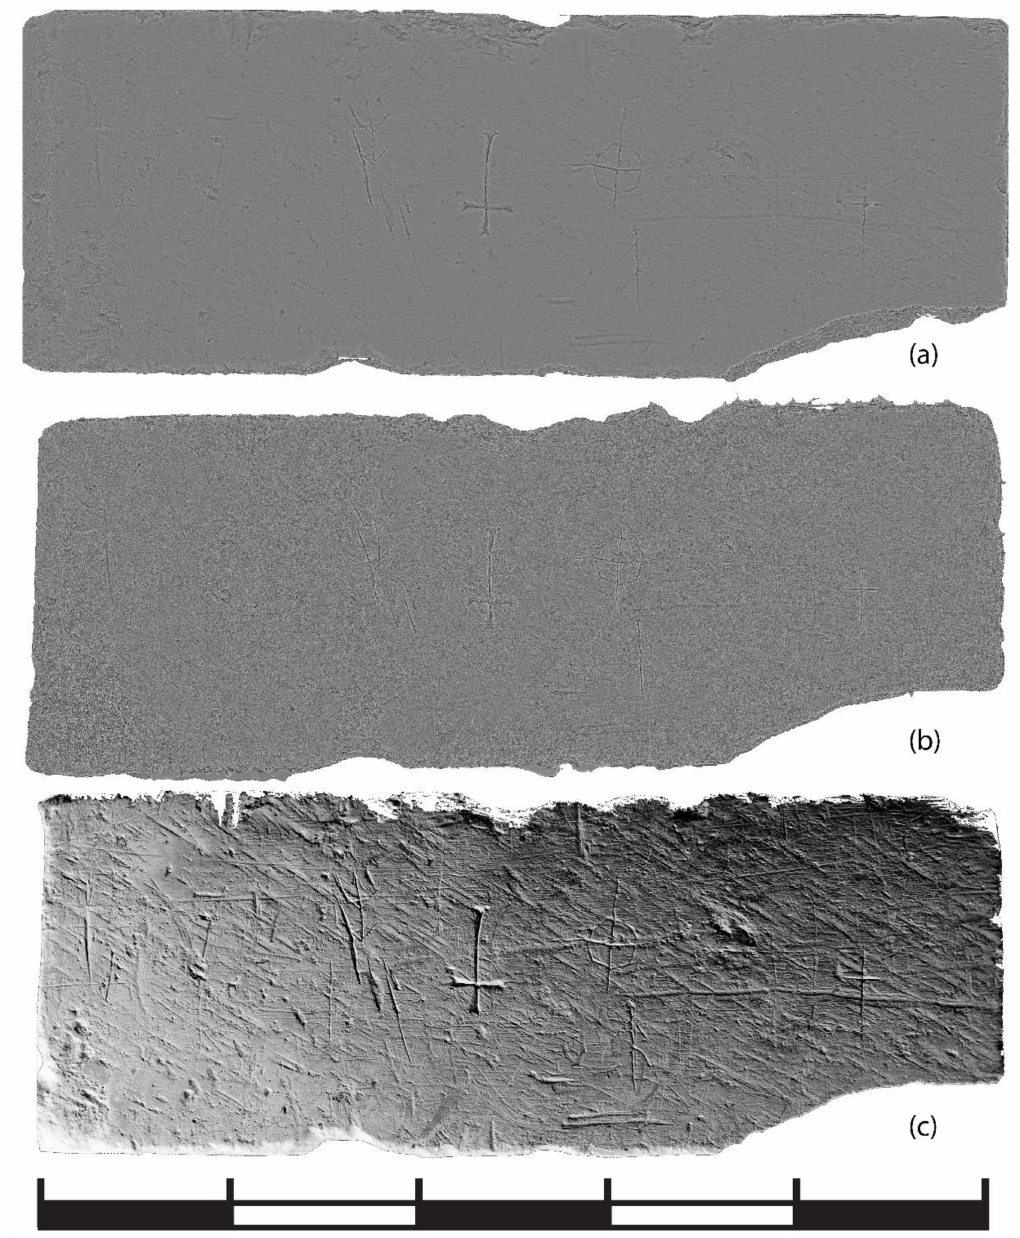
Figure 3. Surface A. ( a ) IBM-RealityCapture (RC); ( b ) Combo 1-RC; and ( c ) Highlight RTI (H-RTI). The scale shown is 50 cm. The RTI model is the most detailed, while the Combo 1 is the most detailed of the 3D models. For practical purposes, only a selection of the results is shown here. All result images, including of the remaining methods, are available in full resolution